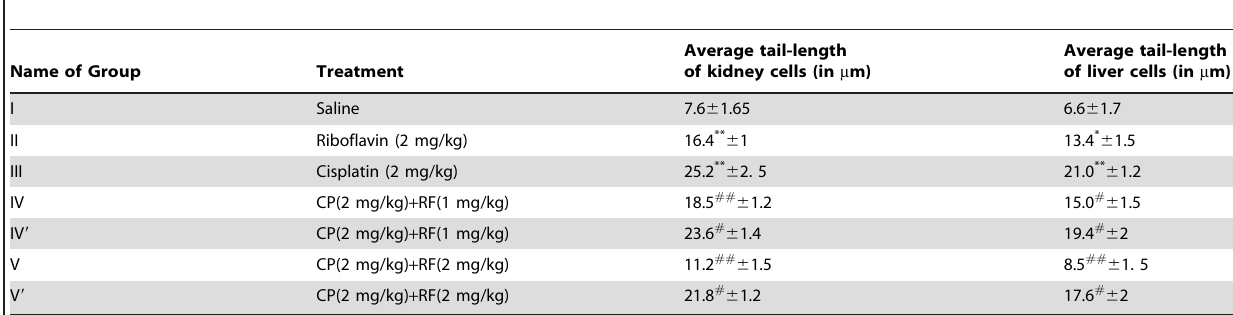
Table 1. Showing the average tail length of comet of the treated cells of different groups.